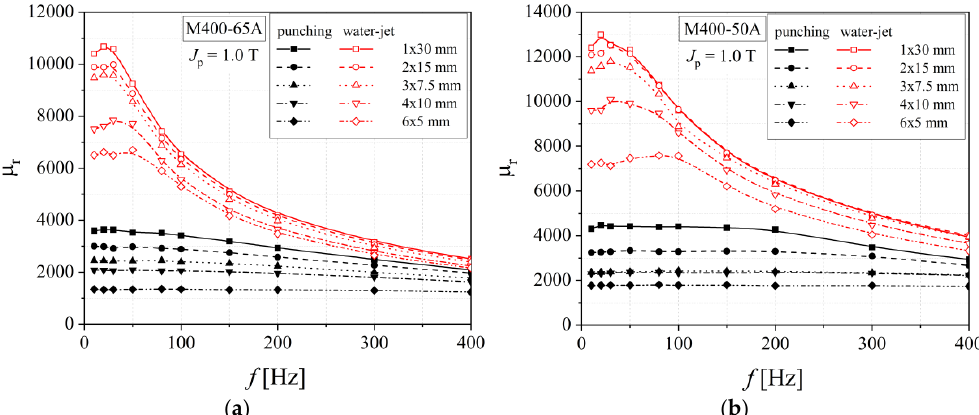
Figure 16. Relative magnetic permeability versus frequency dependencies of electrical steel grade